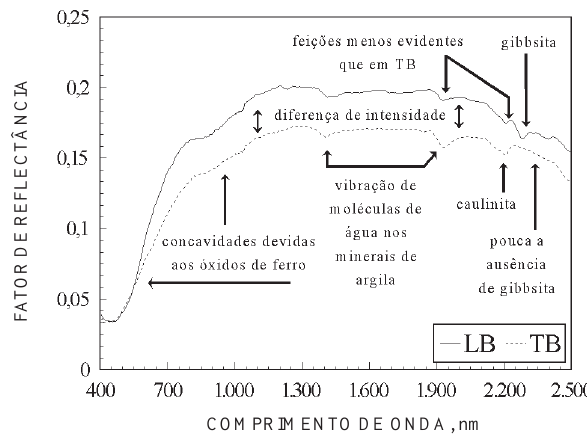
2. Curvas espectrais médias da camada de 0-20 cm do Latossolo Bruno (LB); e da Terra Bruna Estruturada